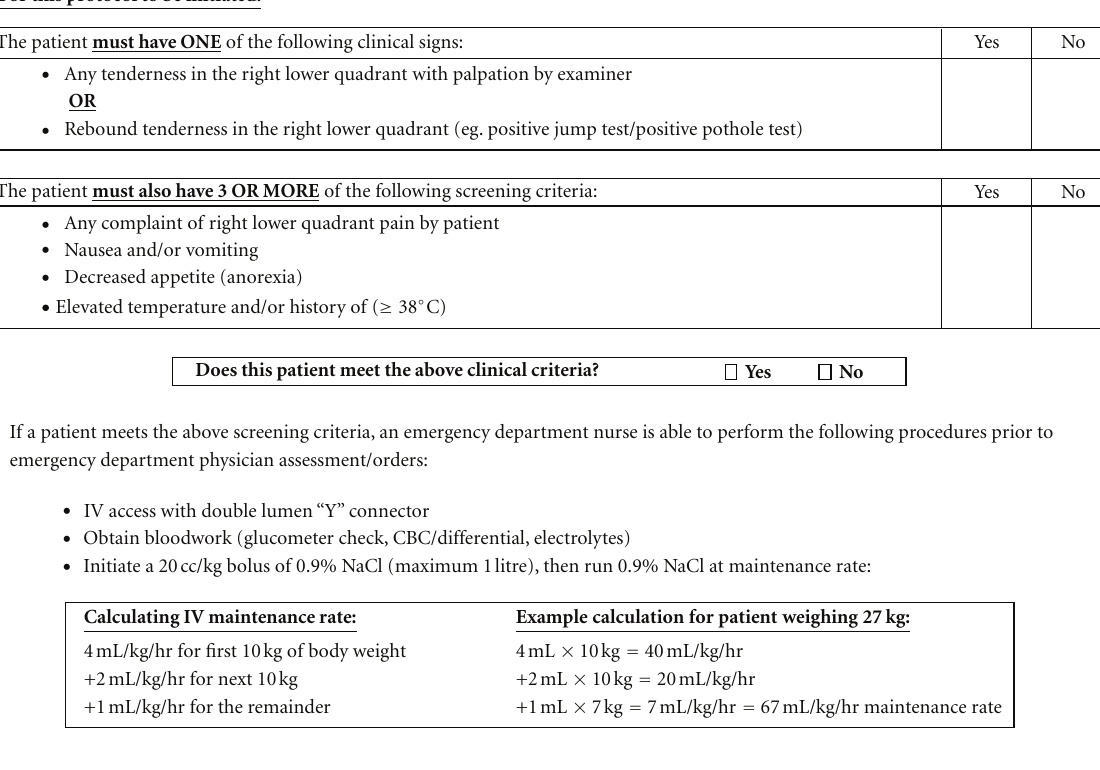
Patient information label